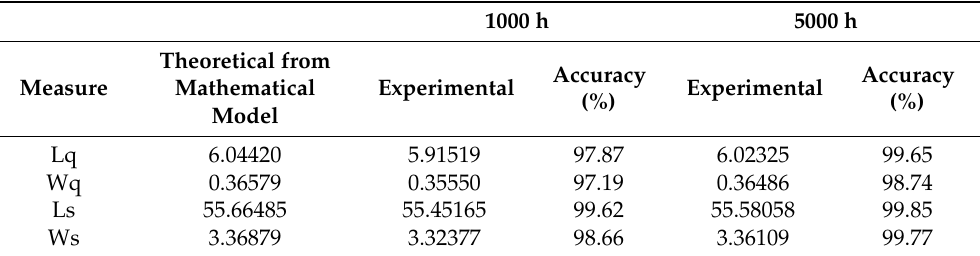
Table 10. Estimation of the accuracy of the parking lot model considering the steady-state perfor- mance